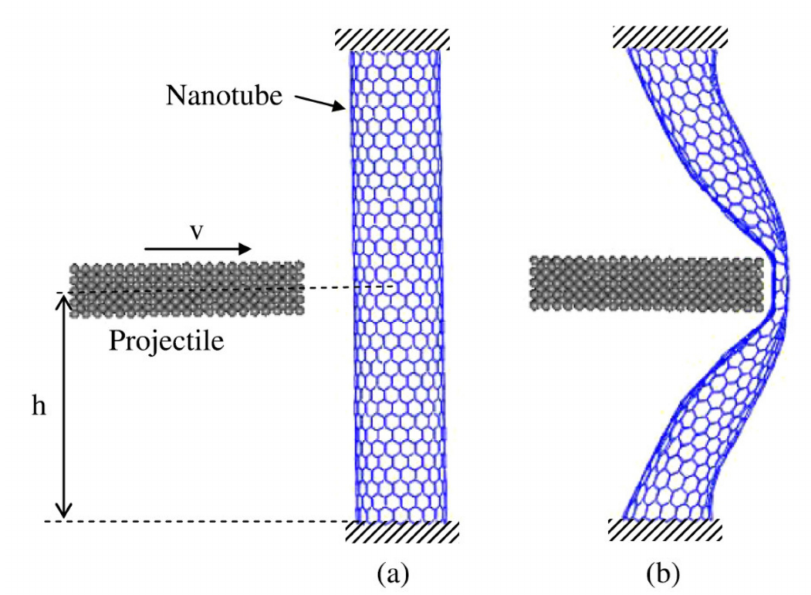
Figure 4. The molecular dynamics model of a CNT subjected to ballistic impact. ( a ) Initial model, ( b ) a deformed (18, 0) nanotube at its maximum energy absorption. Reproduced with permission from [113]. Copyright IOP Publishing,